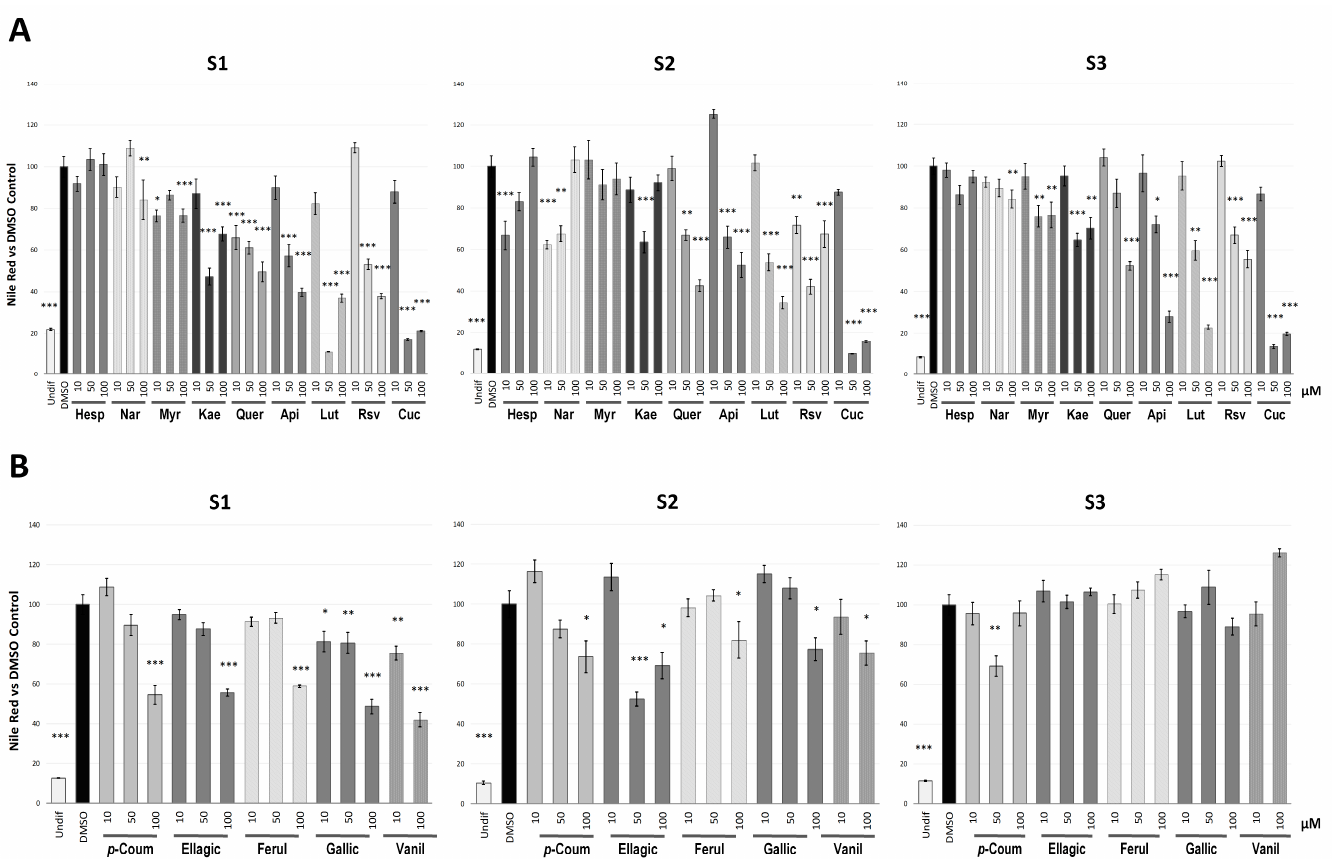
Figure 2. Quantification of the intracellular triglyceride content, measured by Nile red staining, of 3T3-L1 cells after treatment with polyphenols ( A ) and phenolic acids ( B ) along the three stages evaluated (S1, S2 and S3). Results expressed as the mean percentage ( ± SD) of cell triglyceride content relative to DMSO-treated control cells. Undifferentiated 3T3-L1 cells (Undif) were used as positive control. Significance refers to the effect of each treatment with respect to DMSO-control cells (* p < 0.05; ** p < 0.01; *** p < 0.001). Cells were collected on day 8, day 13 and day 16 for the S1, S2 and S3 analyses, respectively. Abbreviations: Hesp (hesperidin), Nar (naringin), Myr (myricetin), Kae (kaempferol), Quer (quercetin), Api (apigenin), Lut (luteolin), Rsv (resveratrol), Cur (curcumin), p -Coum ( p -coumaric acid), Ellagic (ellagic acid), Ferul (ferulic acid), Gallic (gallic acid), Vanil (vanillic acid).